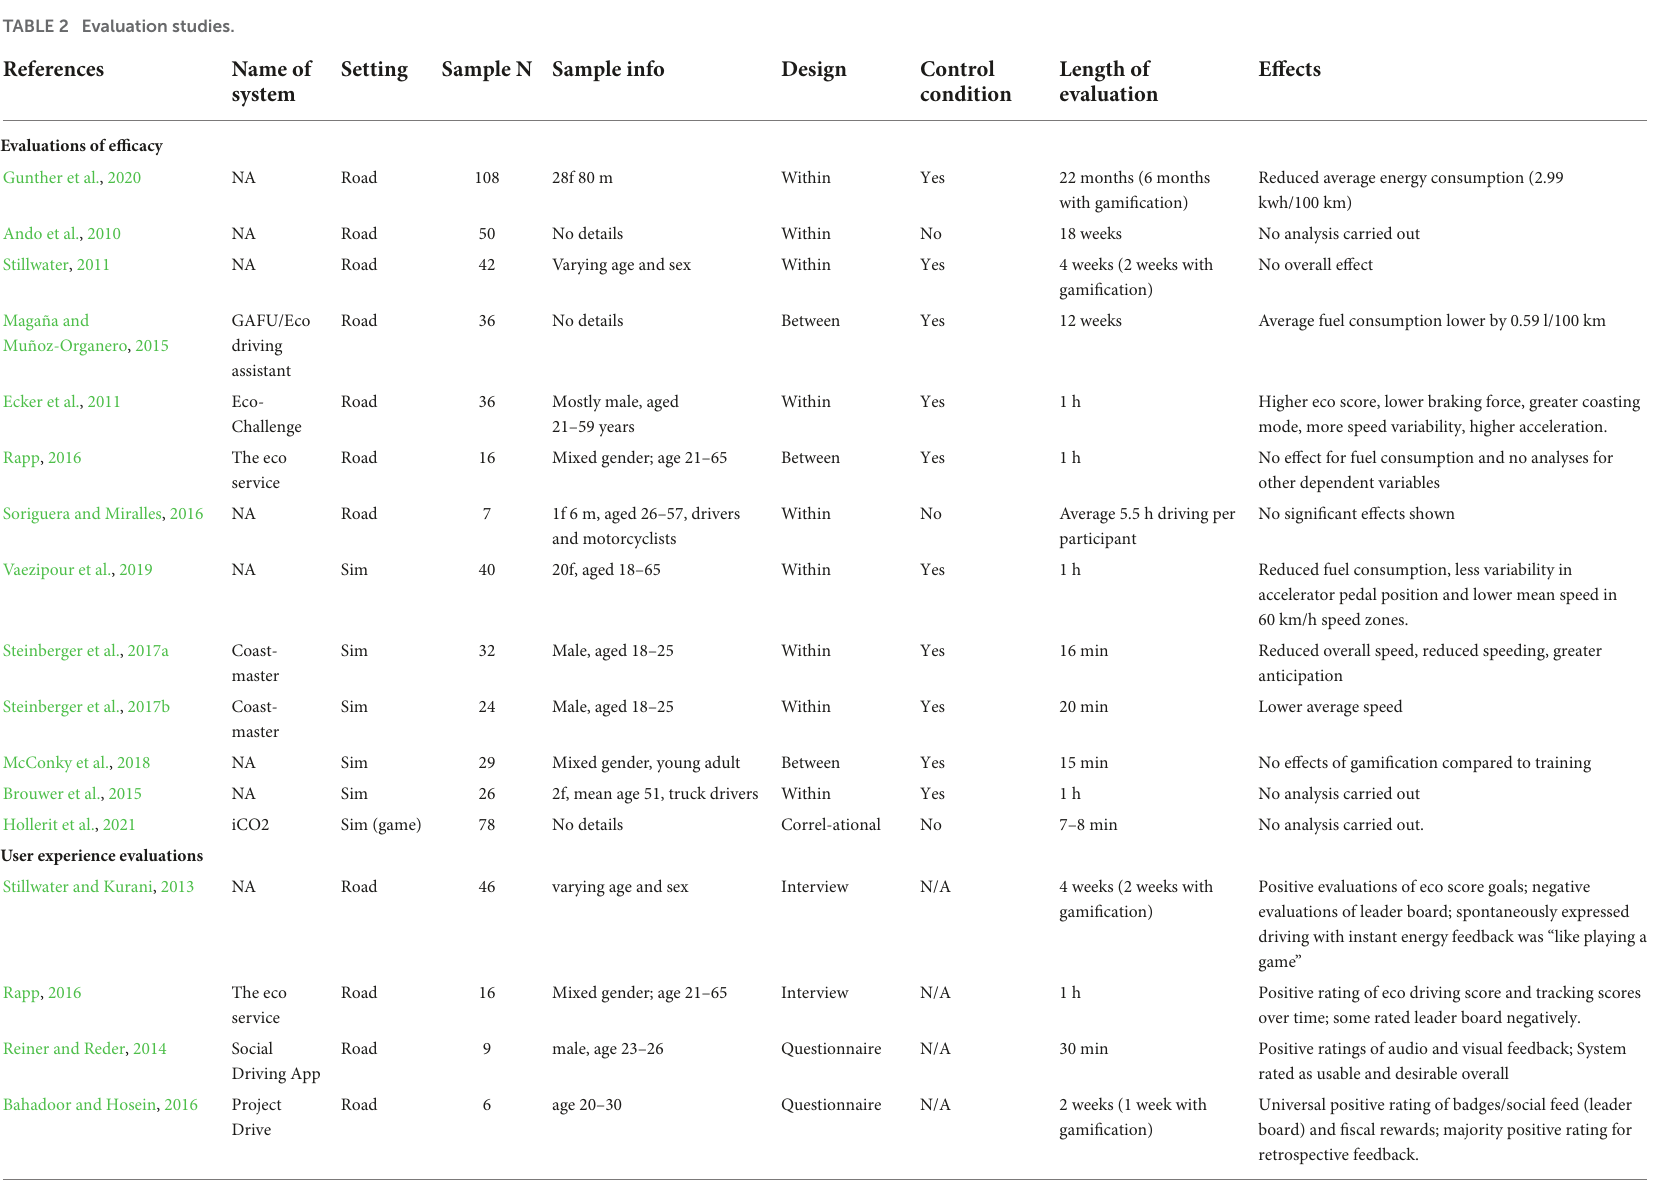
TABLE 2 Evaluation